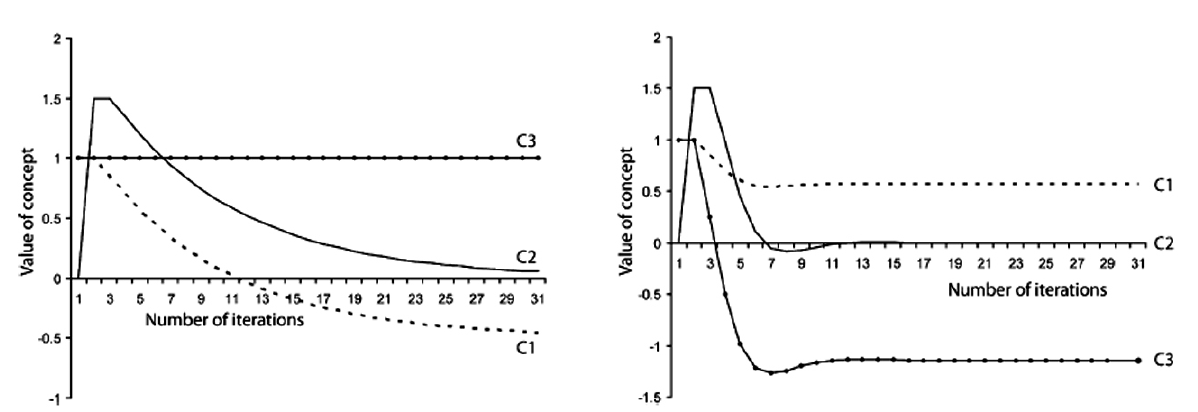
Fig. 2. FCM stabilization and value convergence points (Kok 2009: